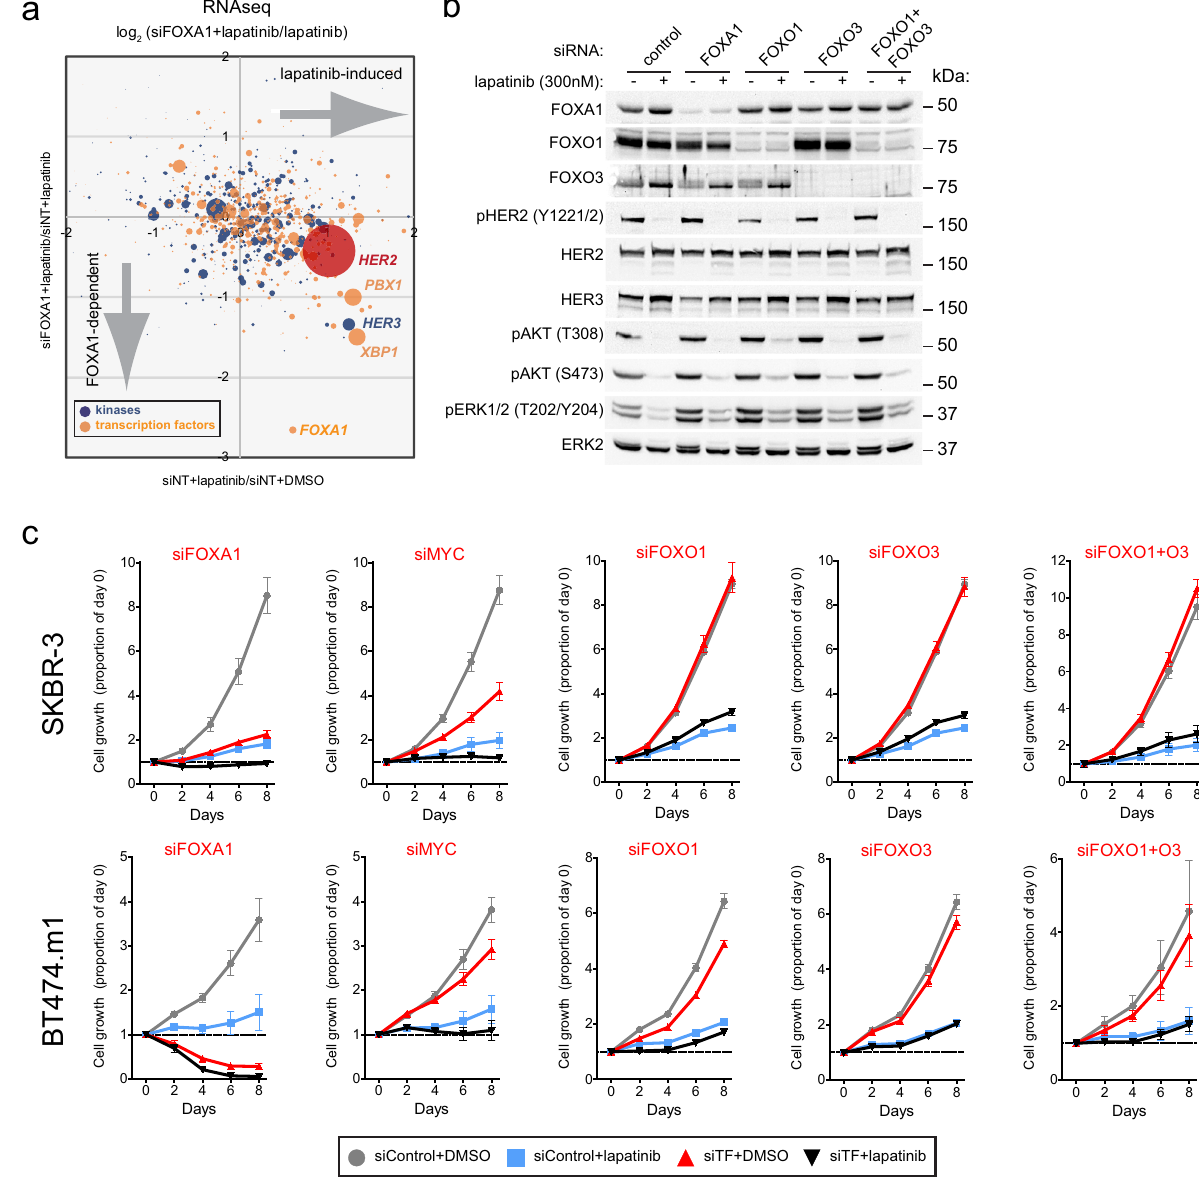
Fig. 3 FOXA1 is critical for the HER2 targeting response and for proliferation in HER2 + cell lines. a RNAseq was performed on SKBR-3 cells treated with DMSO or 300 nM lapatinib for 24 h after treatment with a non-targeting (NT) siRNA pool or FOXA1 siRNA pool. The log 2 fold changes in response to lapatinib are plotted as the NT siRNA effect ( x -axis) versus FOXA1 siRNA effect ( y -axis) for kinases (blue) and transcription factors (orange). HER2 is indicated in red. Dots sizes are scaled relative to their expression level. b SKBR-3 cells were treated with siRNA as in ( a ), then DMSO or 300 nM lapatinib for 24 h, harvested and subjected to immunoblotting to detect the indicated proteins. ERK2 was used as a loading control. c SKBR-3 and BT474.m1 cells were transfected with a NT siRNA pool or siRNA pools targeting the indicated transcription factor (TF) and then treated with DMSO or 300 nM lapatinib for 8 days. Cell growth was quanti fi ed every two days and plotted as the proportion of day 0 cell count. Data are plotted as mean ± s.d. for six